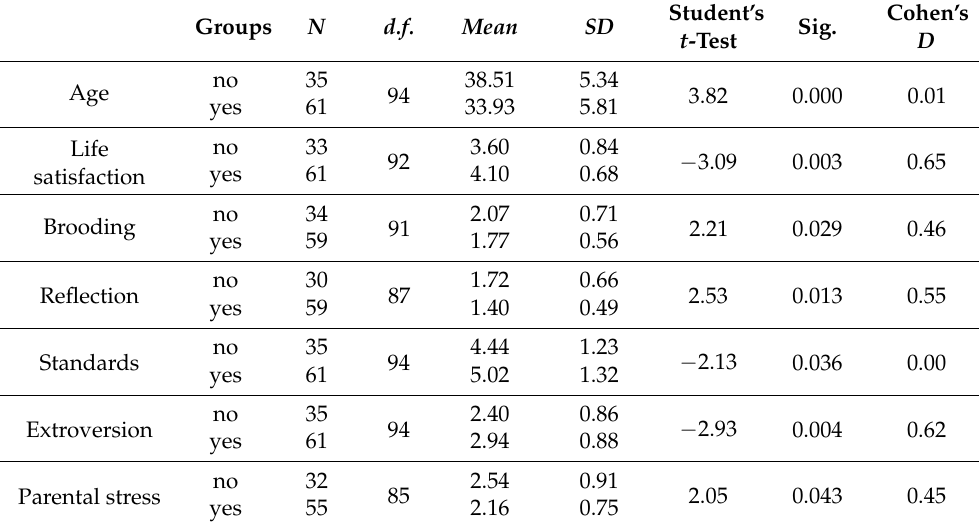
Table 1. Differences in age, life satisfaction, self-criticism, rumination, standards, extroversion and stressors in relation to the predisposition to have more than one